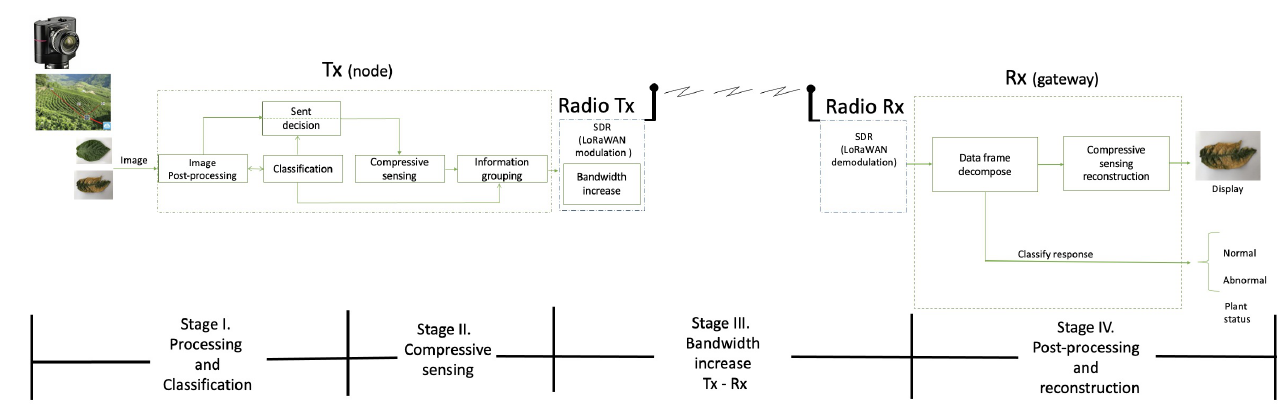
Figure 1. Framework to transmit and receive LoRa